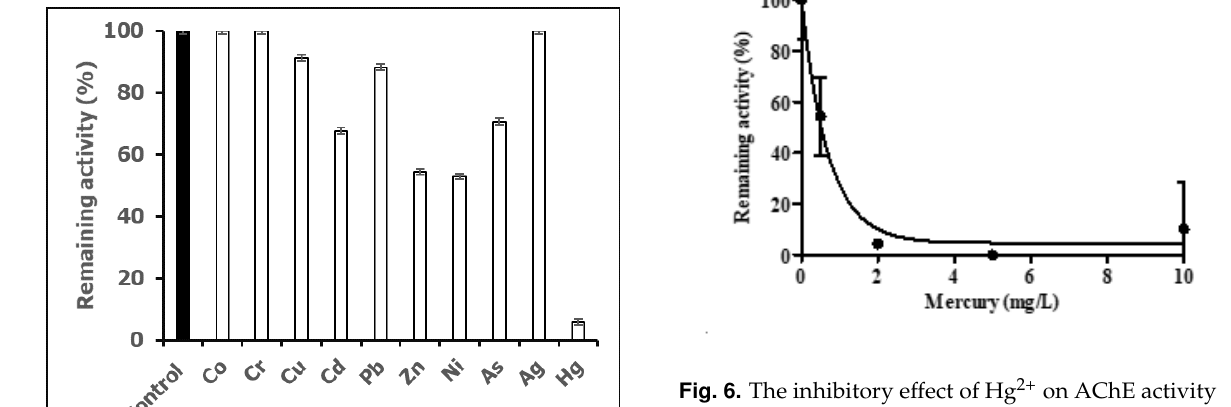
Fig. 6. The inhibitory effect of Hg 2+ on AChE activity from Diodon hystrix